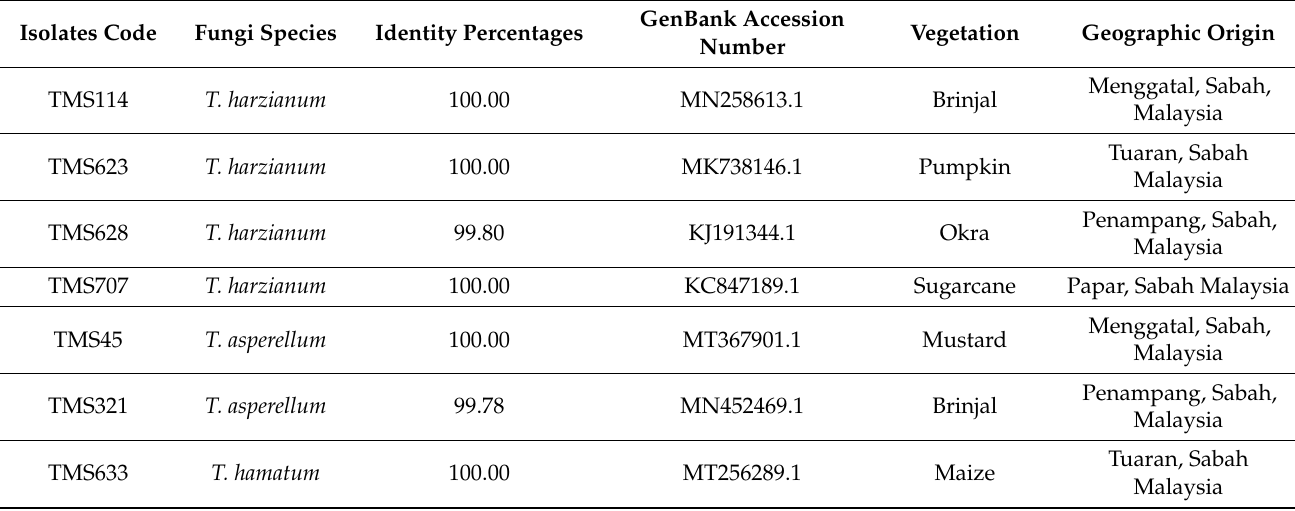
Table 1. Details of fungi isolates used in the